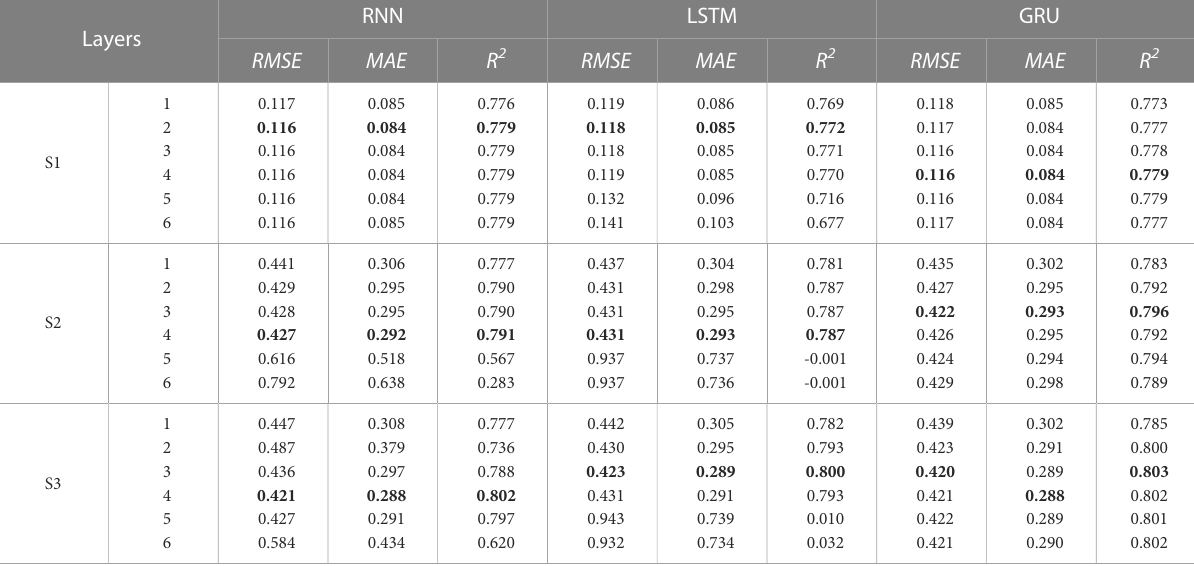
TABLE 4 The prediction result of signi fi cant wave height.